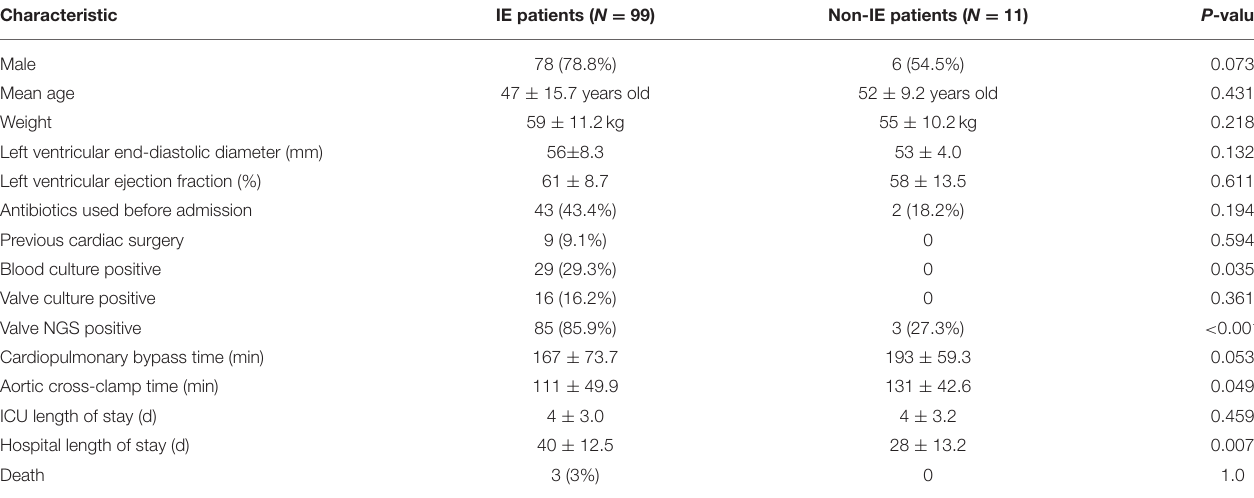
TABLE 1 | Clinical characteristics of 110 patients with valvular heart disease.